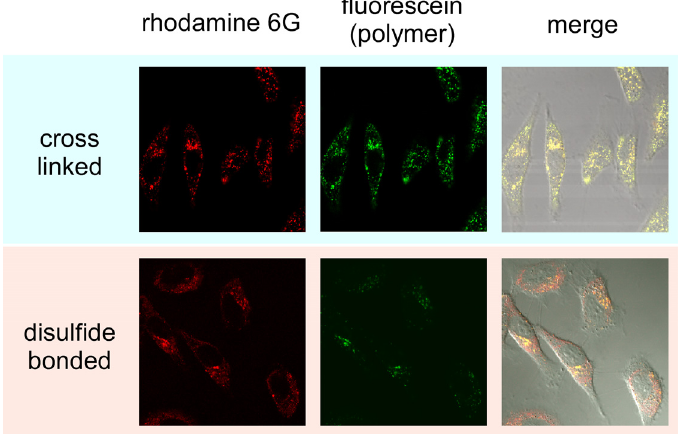
Figure 8. Confocal microscope images of HeLa cells treated by cross-linked and disulfide-bonded